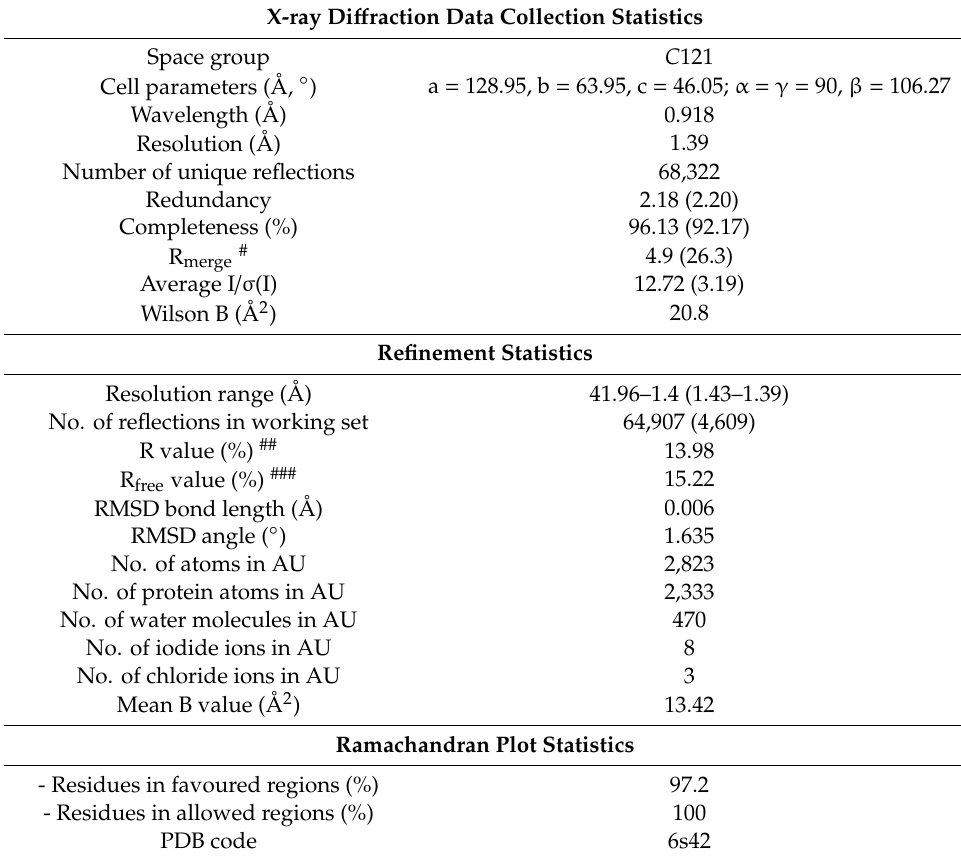
Table 2. Data collection and crystallographic